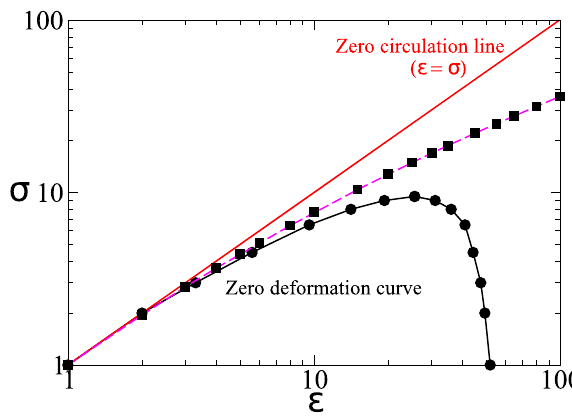
Fig. 5 Circulation-deformation map. Zero circulation line and zero deformation curve in ε − σ space for O c = 10 ( fi lled circles) and O c = 0.01 ( fi lled squares) for AC electric forcing with Ω = π /50. The corresponding DC fi eld result is shown by the dashed magenta line. Note that in the DC case, the zero deformation curve is independent of O c